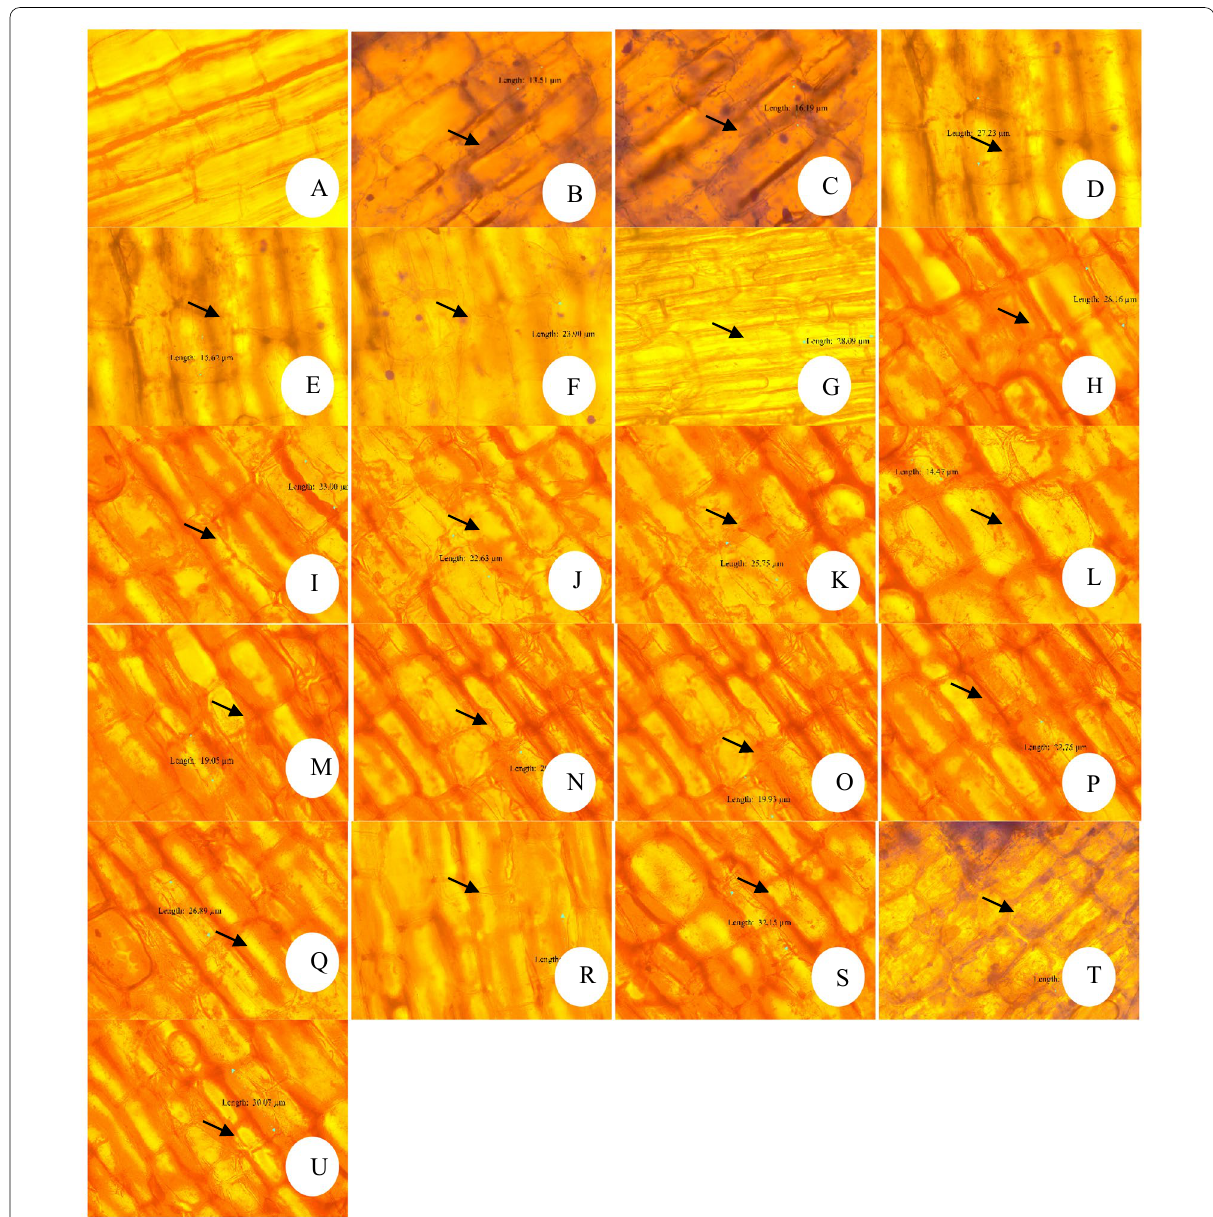
Fig. 1 Young maize tissues colonized by endophytic fungal species: Control ( A ); Chaetomium sp. isolates of GaTpeOi ( B ), JgTjPr ( E ), PiCrPga ( G ), and CaCjPga ( O ); Aspergillus niger isolates of PsgTjPr ( C ), JgByU ( P ), and JaBuBys ( R ); Beauveria bassiana isolates of JgSPK ( D ), JaGiP ( F ) JaSpkPGA(2) ( K ), JgCrJr ( L ), and JaTpOi(1) ( M ); Curvularia lunata isolates of JaGiPRB ( H ), CMTJP ( I ), JaMsBys ( J ), JaSpkPga(3) ( N ), and JgTgSr ( Q ); Aspergillus flavus isolate of JgPWSR ( S ); Penicillium citrinum isolate of JaTpOi(2) ( T ); and Metarhizium anisopliae isolate of CaTpPga ( U